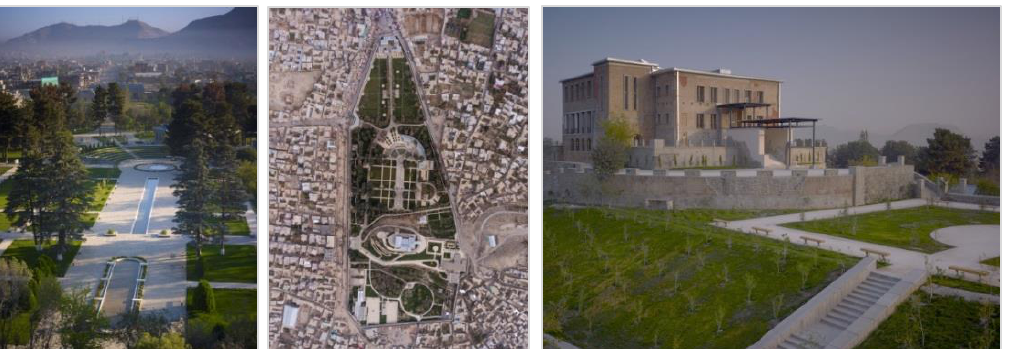
Figure 9 Different views of Chihilsitoon Garden and Palace (Jodidio, 2017).